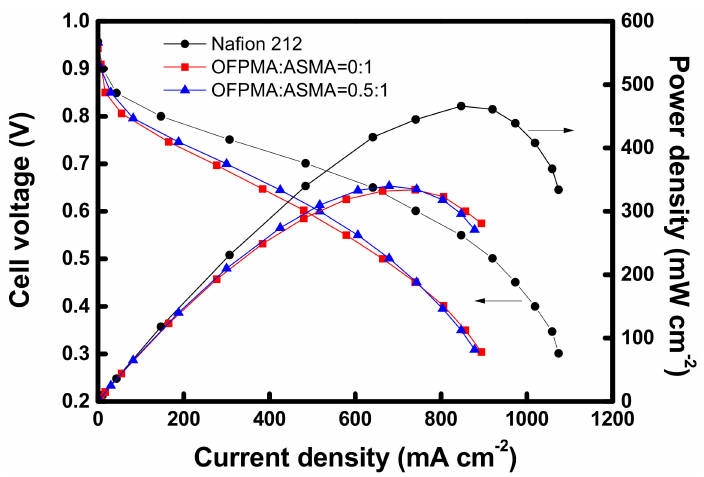
Figure 8. I–V and power density curves of the MEAs employing commercial membrane and prepared PFPEMs,